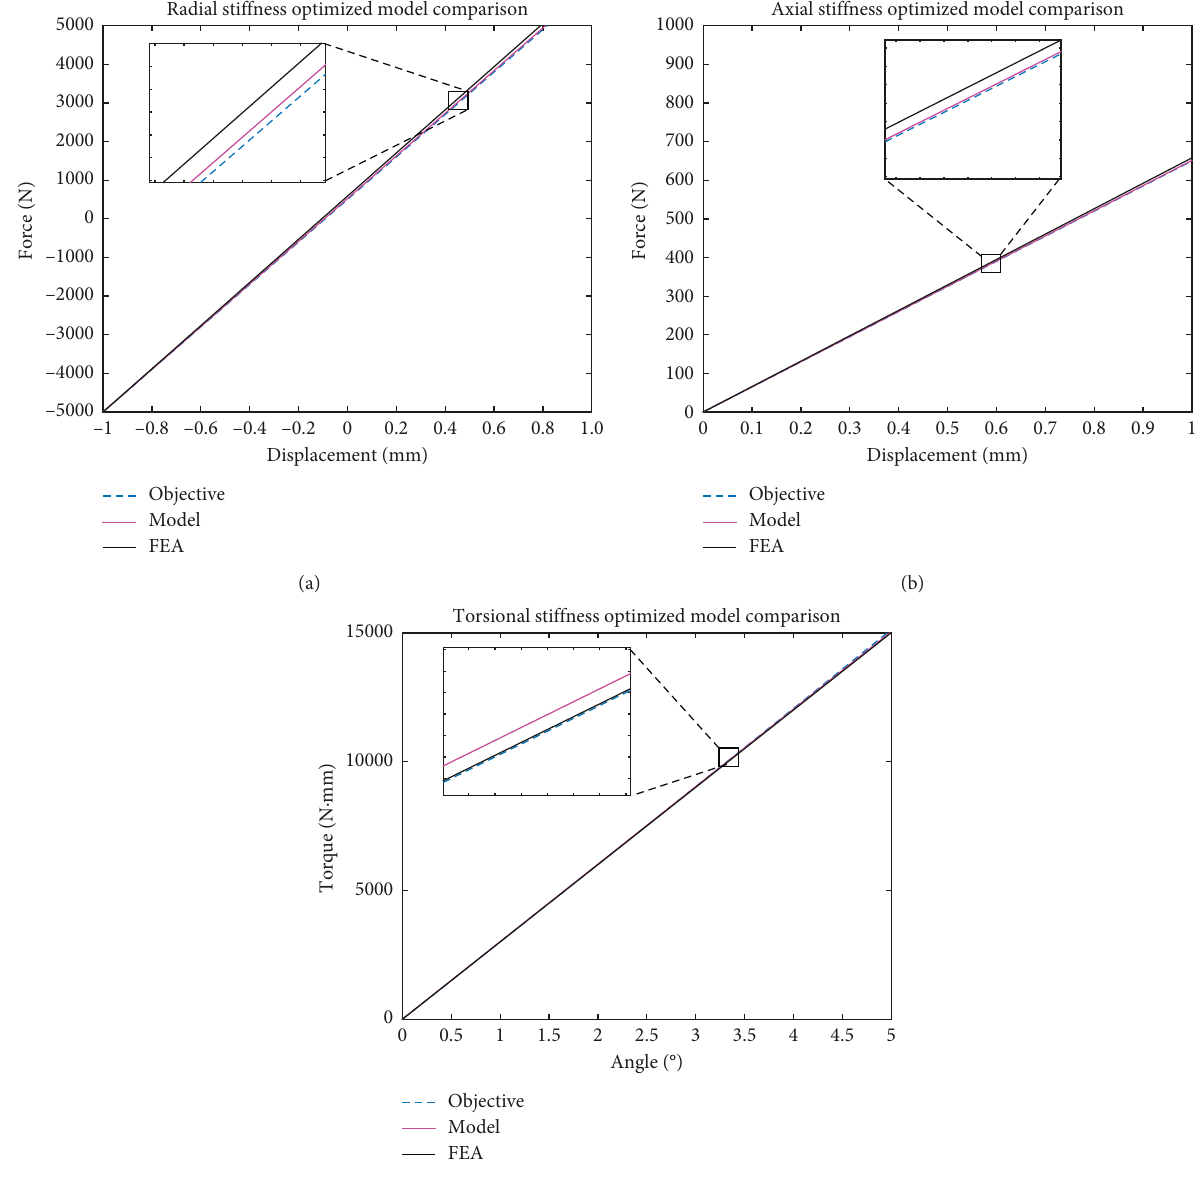
Figure 11: Stiffness requirements, mathematical model, and finite element method of the optimized model. (a) Radial stiffness optimized model comparison. (b) Axial stiffness optimized model comparison. (c) Torsional stiffness optimized model